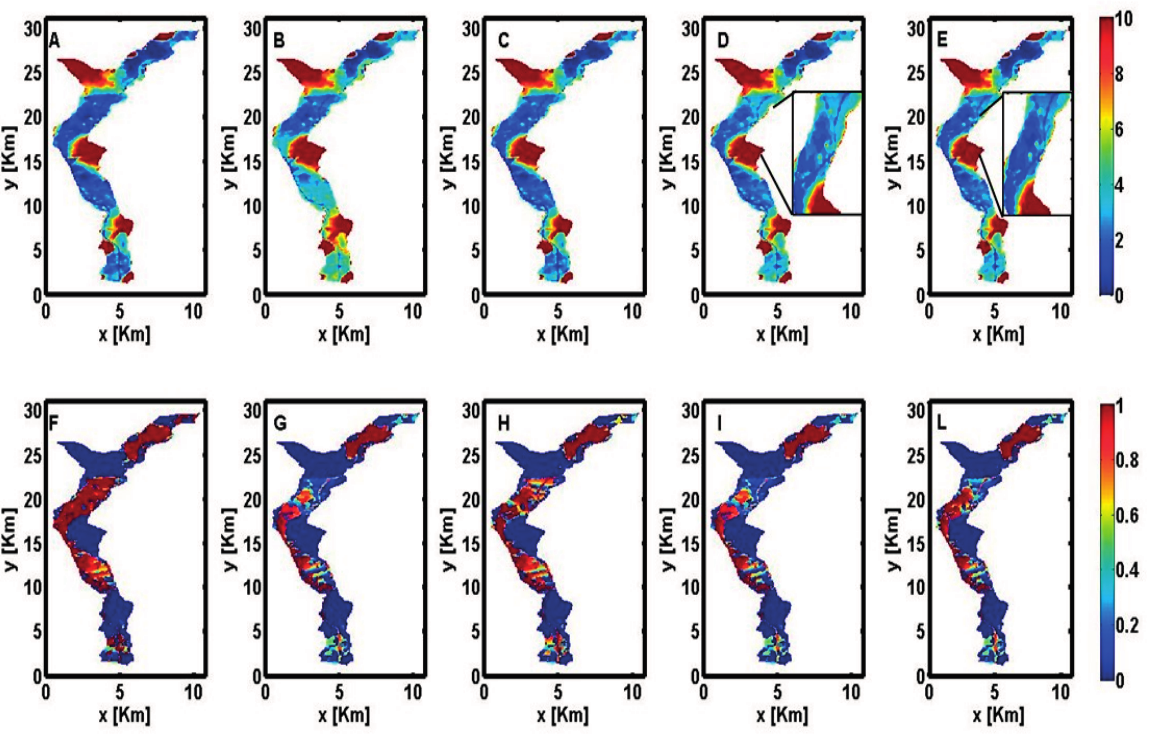
Figure 7. Maps of the mean DTWs for the base case ( A ); and scenarios RS05, PW2, PW5A and PW5B (panels ( B ) to ( E ) in the first row). In addition, probability of DTW not exceeding the threshold of 2 m is shown for the base case ( F ) and the four scenarios RS05, PW2, PW5A, PW5B (panels ( G ) to ( L ) in the second